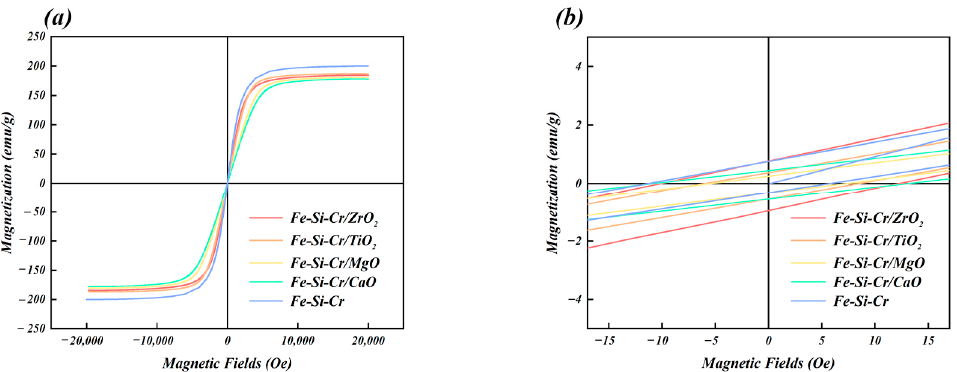
Figure 5. ( a ) Saturation magnetization hysteresis loops and ( b ) local magni fi cation of curves for Fe- Si-Cr SMCs and Fe-Si-Cr/AO x soft magnetic composite cores at room